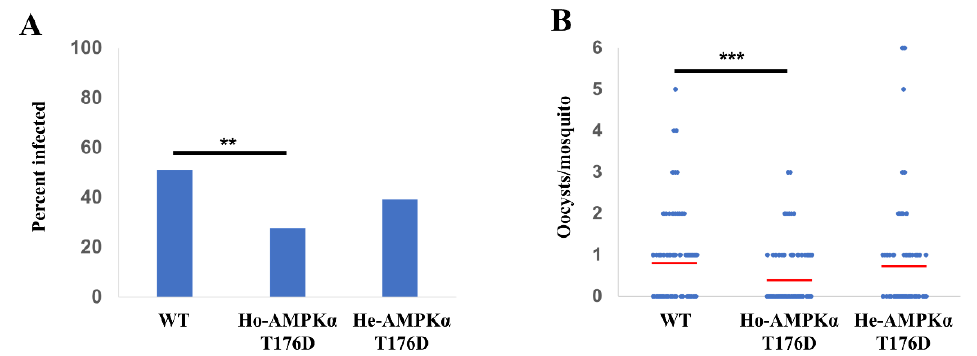
Figure 7. HA-AMPK α T176D overexpression reduces Plasmodium falciparum infection prevalence and intensity. Transgenic (hemizygous and homozygous) mosquitoes and wild type controls were provided with an artificial bloodmeal enriched with P. falciparum NF54 gametocytes. Ten days after infection, midguts were dissected and the numbers of P. falciparum oocysts were counted. ( A ) Prevalence reflects the percentage of mosquitoes infected with at least one oocyst in the midgut. ( B ) Intensity of infection reflects the mean number of oocysts found in infected mosquitoes. The mean numbers of oocysts per midgut ± SEMs are plotted. WT n = 91; homozygous TG n = 94; hemizygous TG n = 87. Infection prevalence was analyzed by Fisher’s exact test and intensity by Mann–Whitney (** p < 0.01, *** p < 0.001).